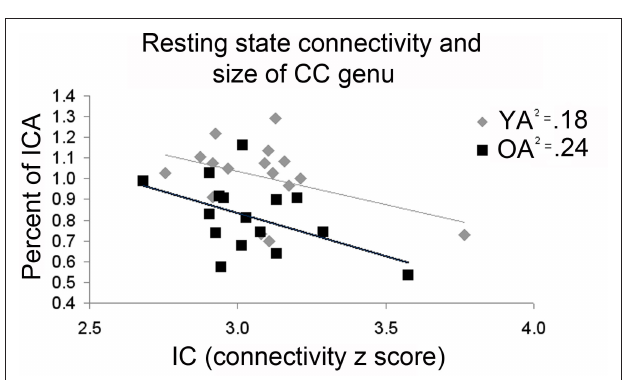
FIguRe 9 | Older adults (OA) with smaller area in the corpus callosum genu demonstrated greater interhemispheric connectivity (IC). While young adults (YA) mimicked this pattern, the correlation did not reach statistical